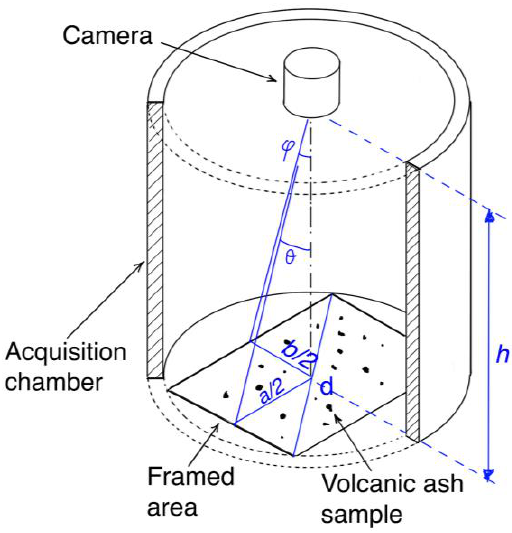
Figure 2. Schematic view of the experimental setup.